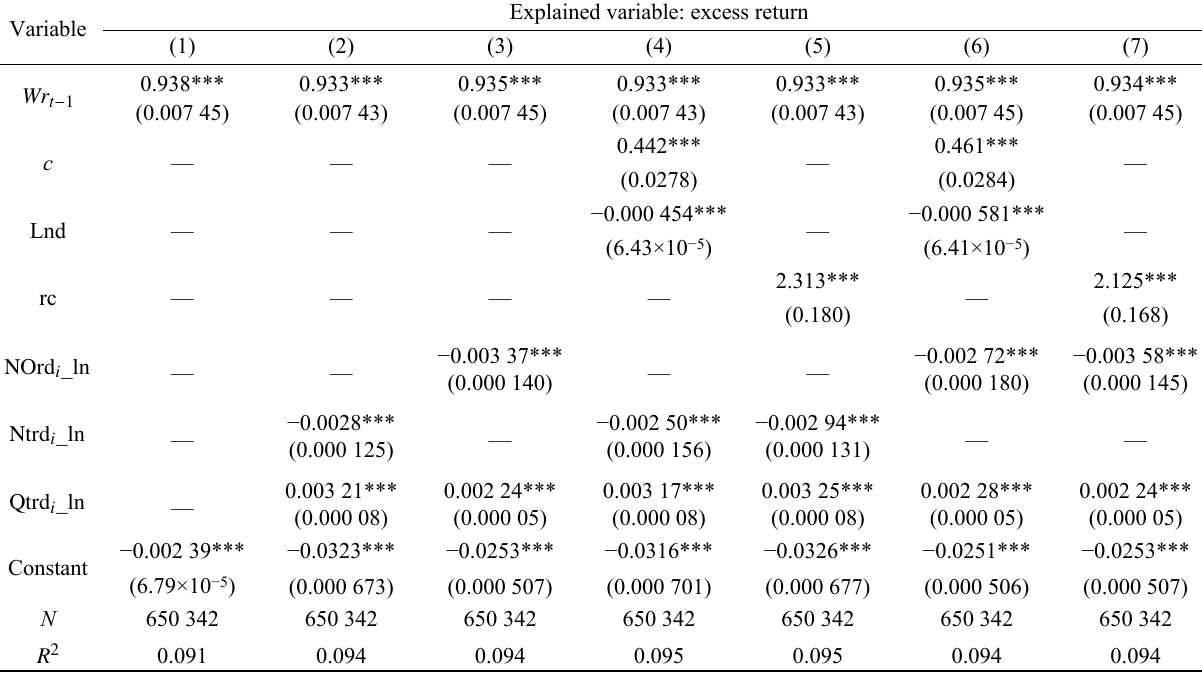
Table 7 Test on behavior spillover mechanism.